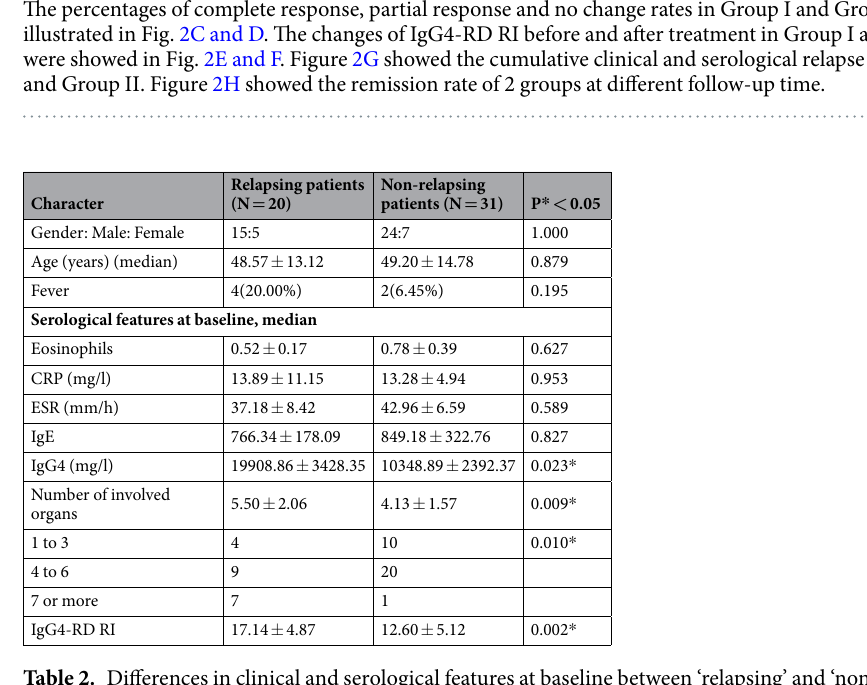
Table 2. Differences in clinical and serological features at baseline between ‘relapsing’ and ‘non-relapsing’ patients in Group